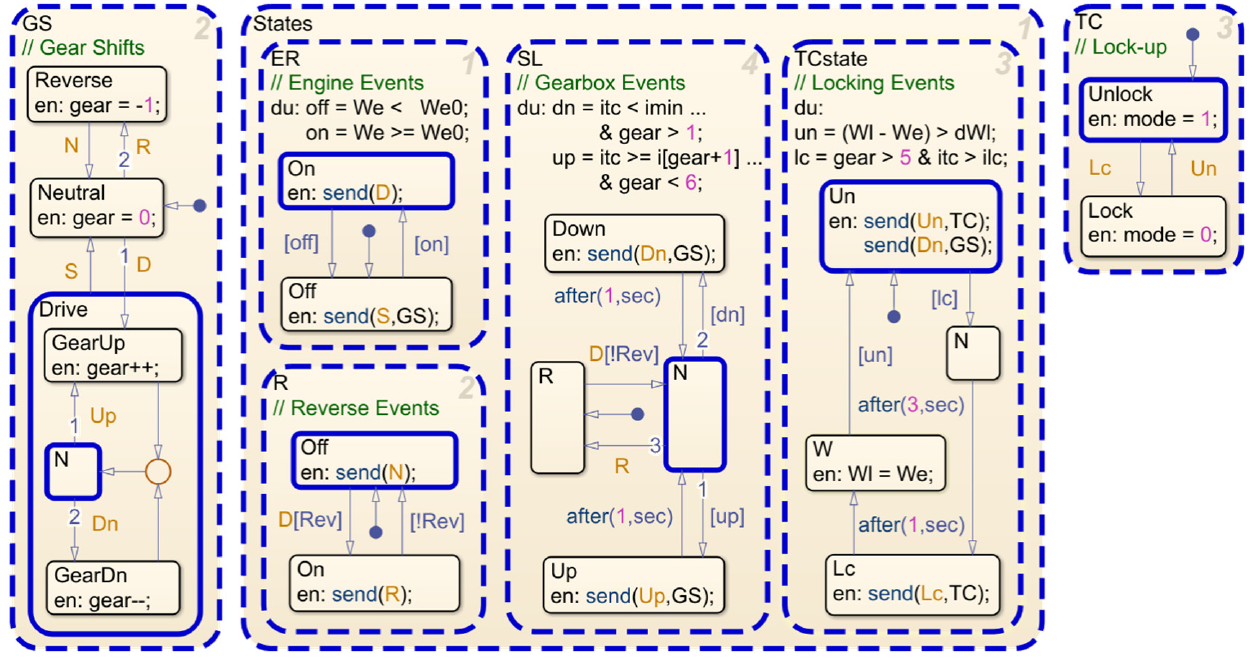
Figure 8. Stateflow chart of drivetrain control logic.